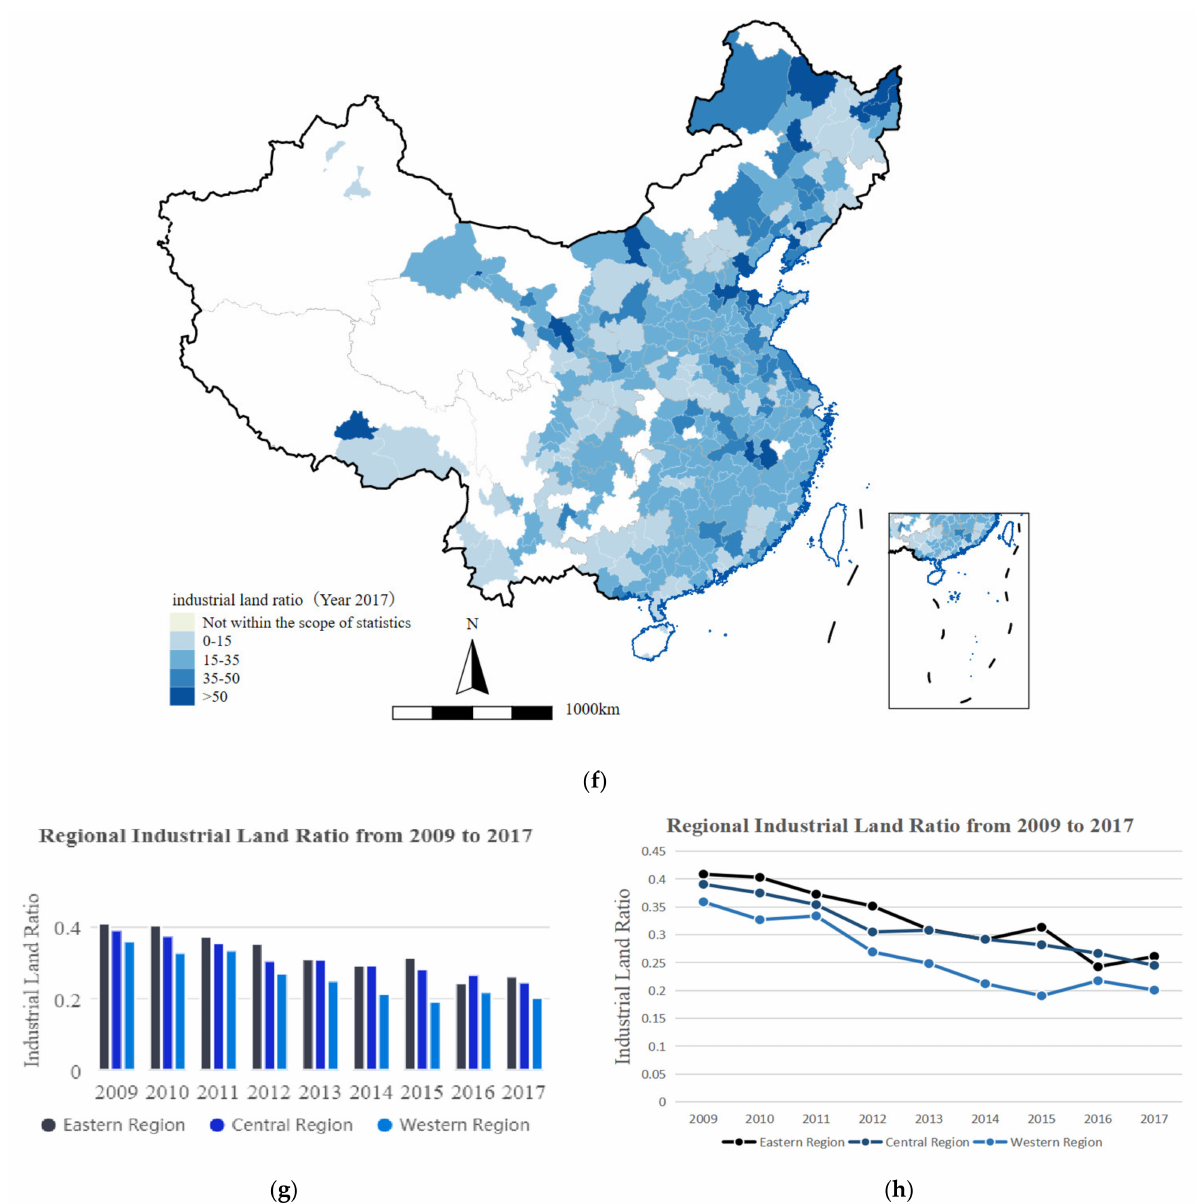
Figure 5. ( a – f ) Industrial land ratio in 2009, 2011, 2013, 2015, 2016, and 2017; ( g , h ) regional industrial land ratio from 2009 to